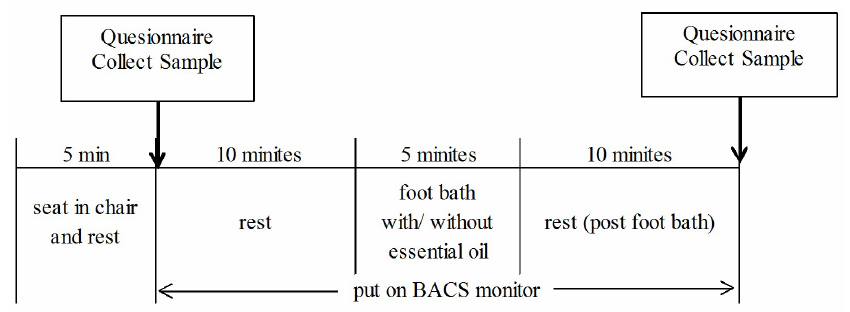
Figure 1. Research protocol.